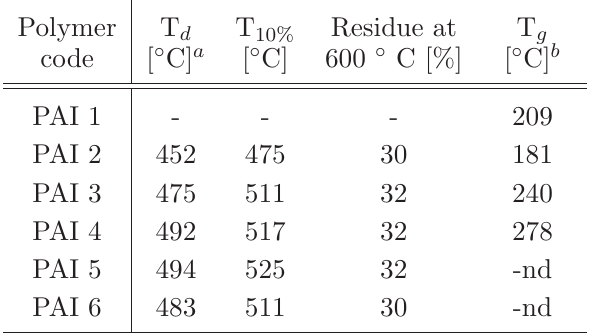
Table 2 Thermal properties of the